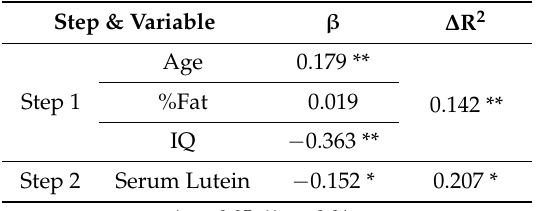
Table 3. Hierarchical linear regression modeling of misplacement and carotenoids.